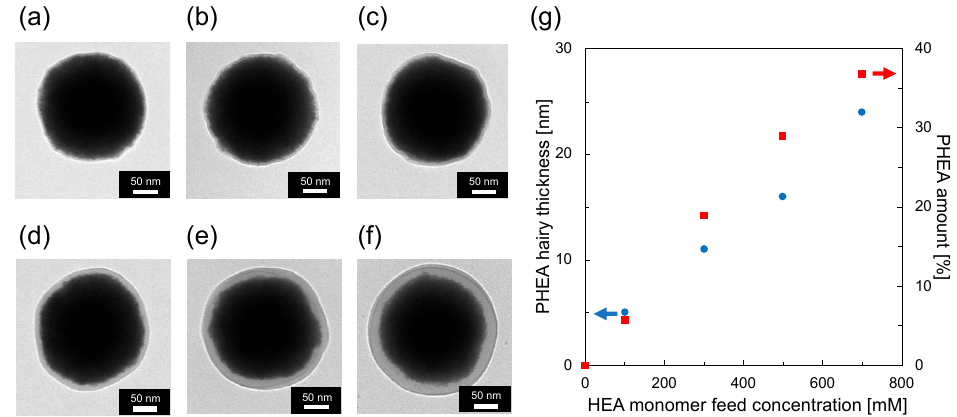
Figure 3. TEM images of ( a ) CeO 2 , ( b ) CeO 2 @PDA, ( c ) CeO 2 @PDA@PHEA(5), ( d ) Figure